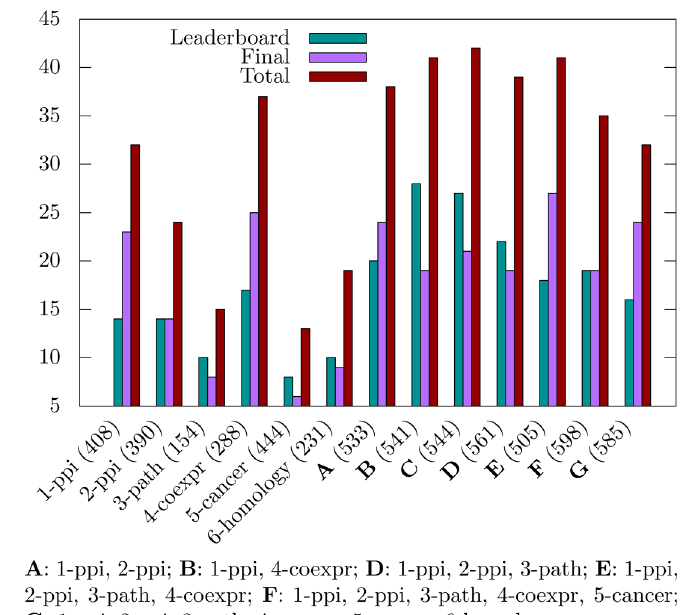
Figure 3. Number of significant disease modules identified for different combinations of multiplex network layers. Ten randomizations have been applied, and the FDR threshold is set to 0.1. The total number of considered communities for each multiplex network is displayed in